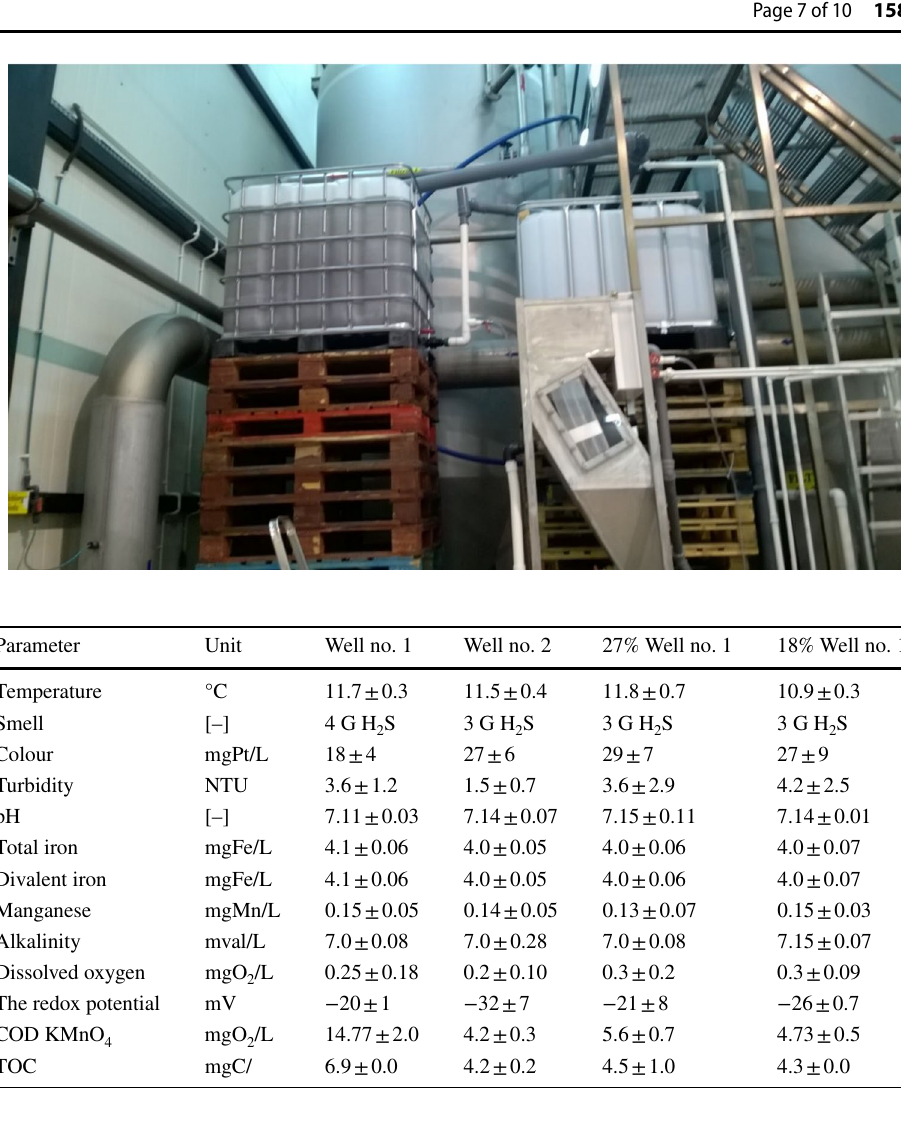
Fig. 5 Changes in the